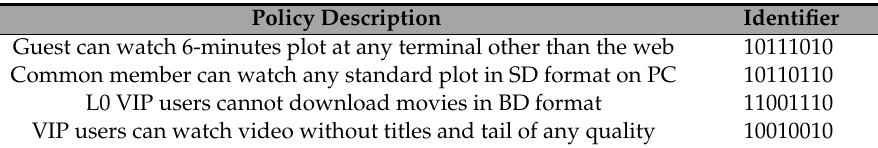
Table 2. Policy description and corresponding binary